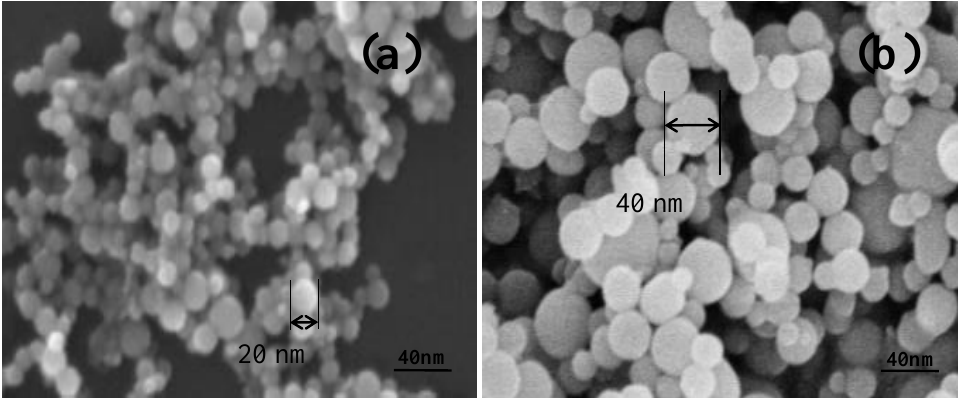
Figure 1. S. Jeong et al. 273 Figure 1. SEM images of Al: ( a ) 20 nm and ( b ) 40 nm nanoparticles.